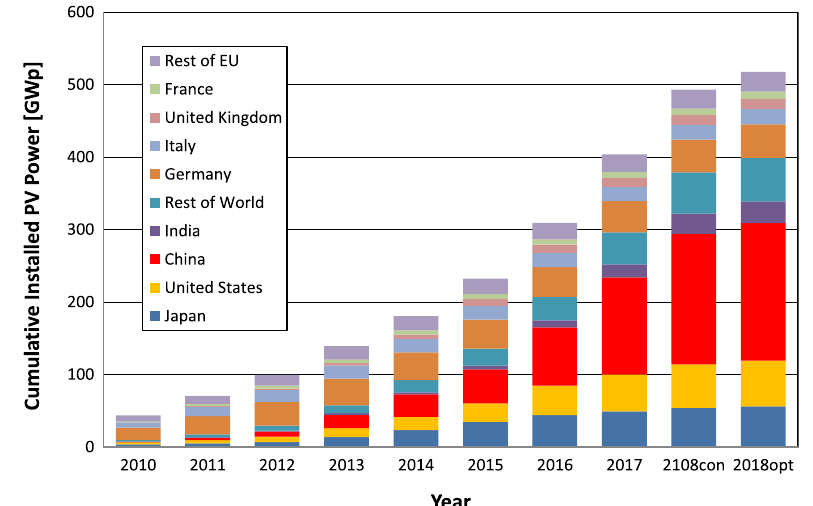
Fig. 3. Cumulative Photovoltaic Installations from 2010 to 2018 (data source: [12,13,14] and